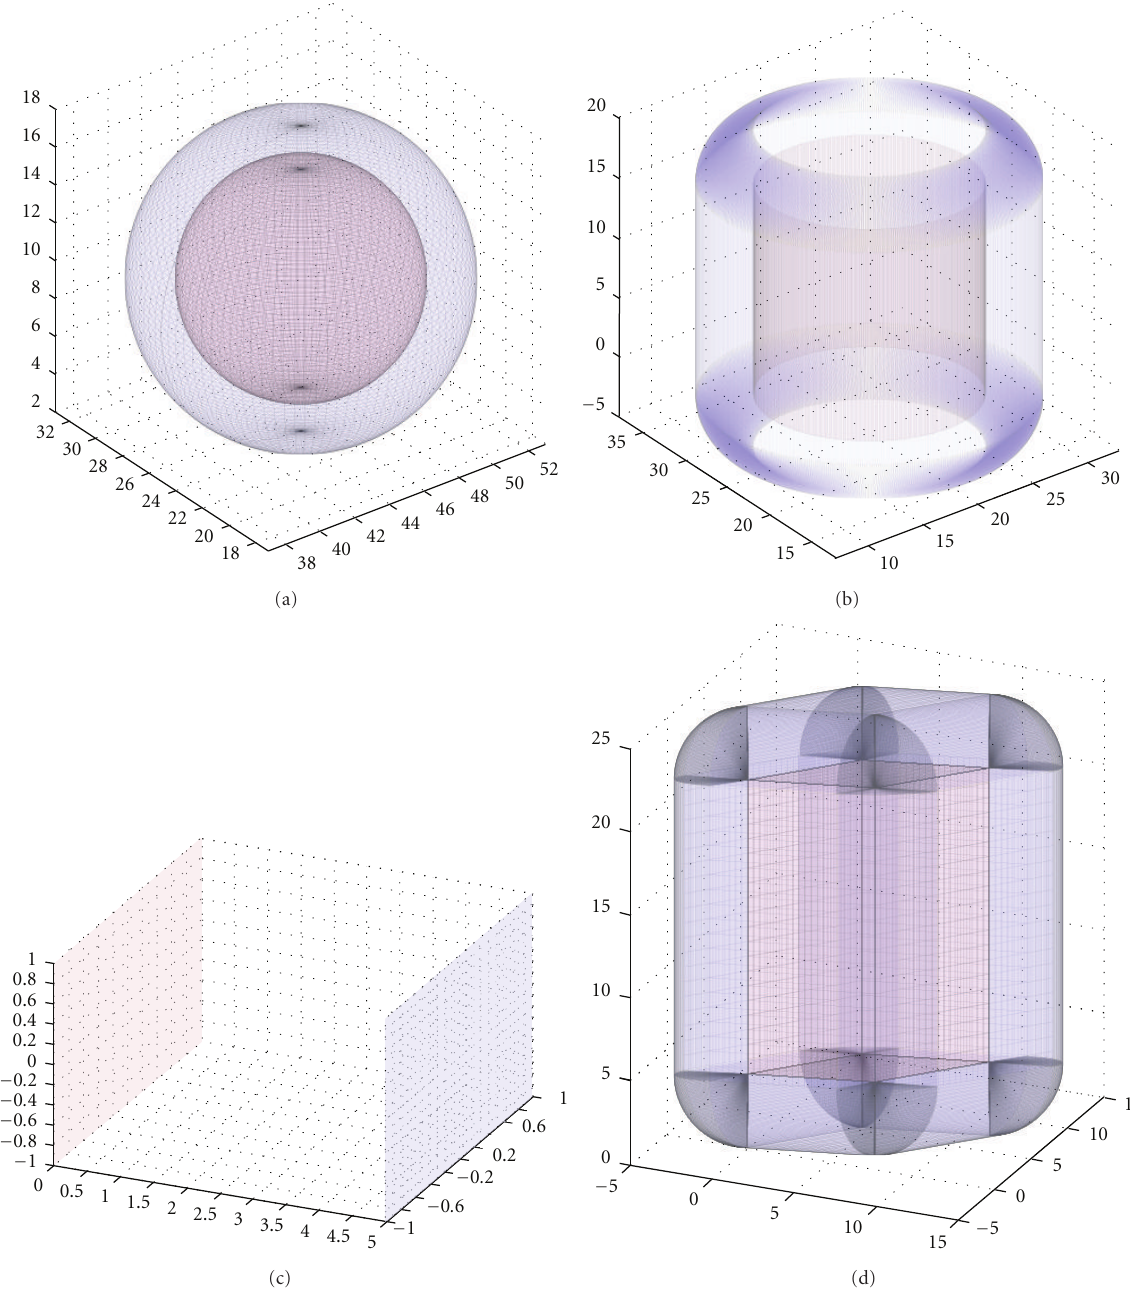
Figure 2: Elementary shapes (a) sphere, (b) cylinder, (c) plane, (d) parallelepiped (red), and their warning zones (blue).